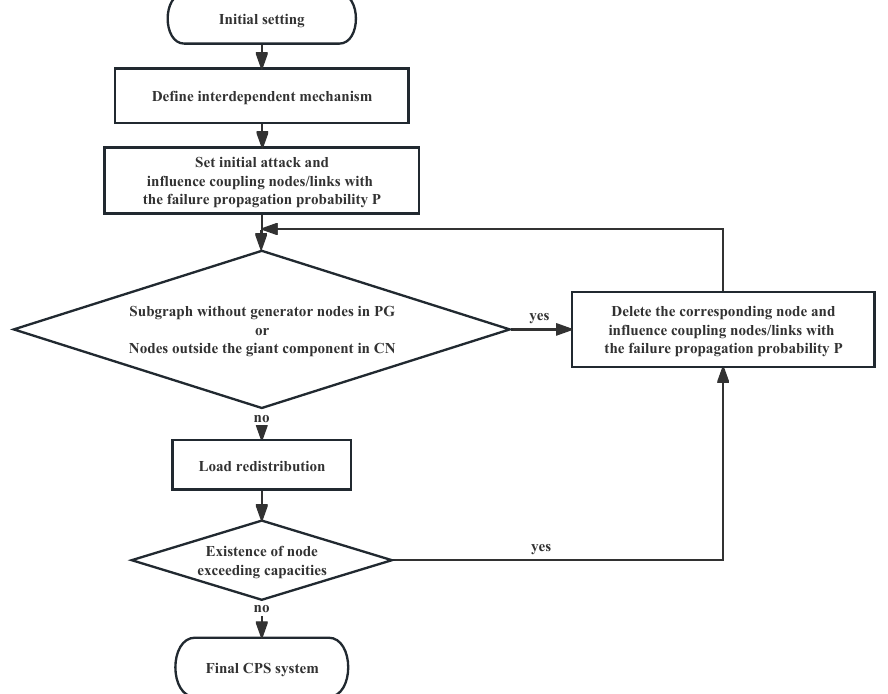
Figure 2. The flowchart of cascading failure process in